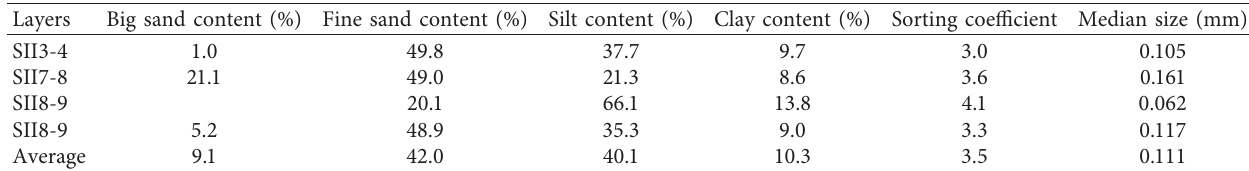
Table 4: SASP granularity analysis data from checking